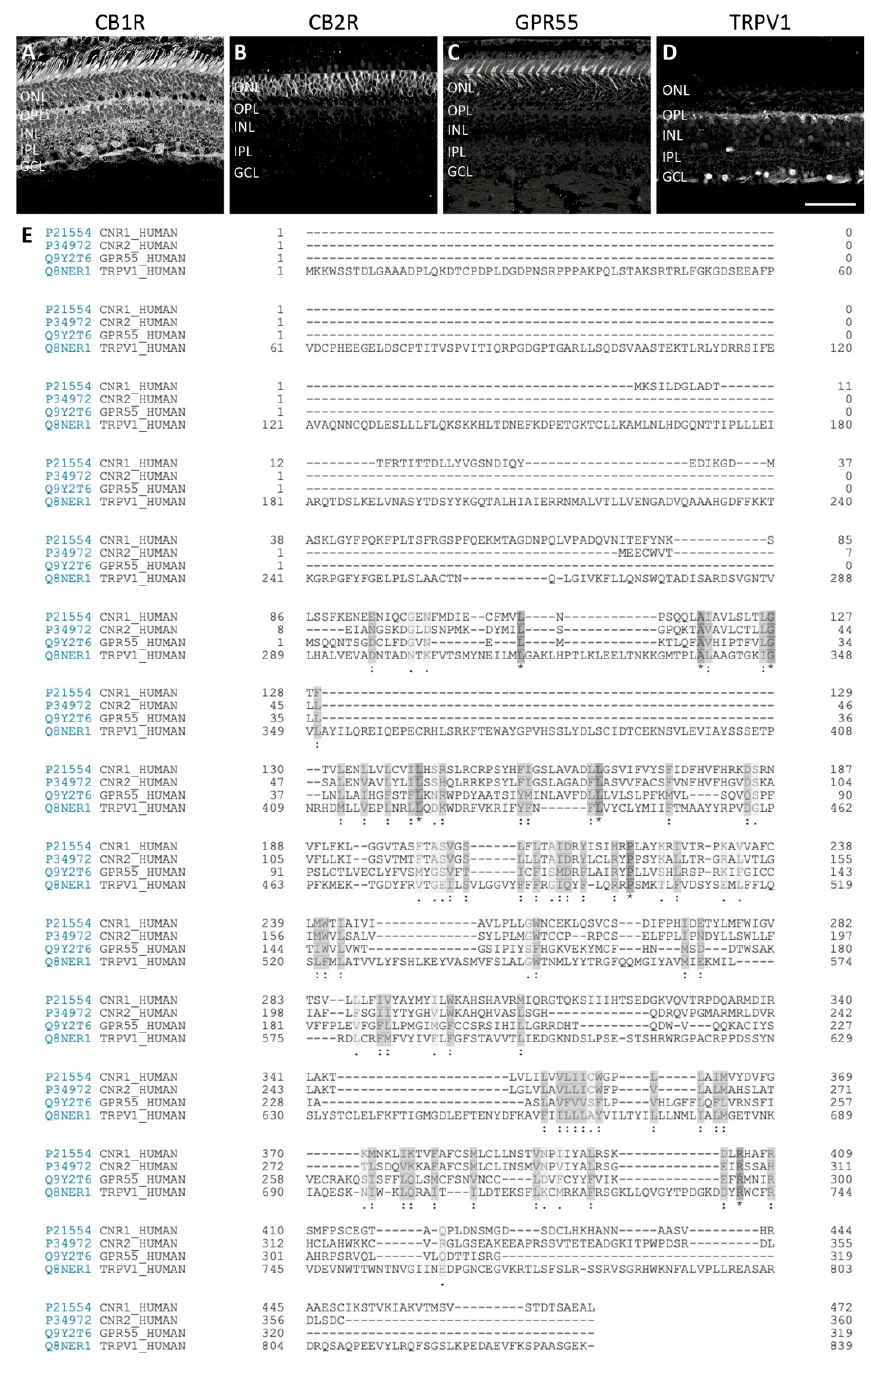
Figure 3. Comparison of typical and atypical cannabinoid receptors. Confocal immunofluorescence images of vervet monkey retinal sections ( A – D ) and human protein sequence alignment ( E ) of CB1R, CB2R, GPR55, and TRPV1. CB1R is localized in neural components, with very weak (albeit absence) in rods [16] ( A ). CB2R is strictly expressed in the glial components, the Müller cells [29] ( B ). GPR55 is found exclusively in rods, with the most prominent staining in the inner segments [28] ( C ). TRPV1 is expressed in the lateral pathway, particularly horizontal cells and amacrine cells [27] ( D ). Protein alignment show conserved regions that may be important for the structural and functional effects of cannabinoids. Scale bar = 75 µm.